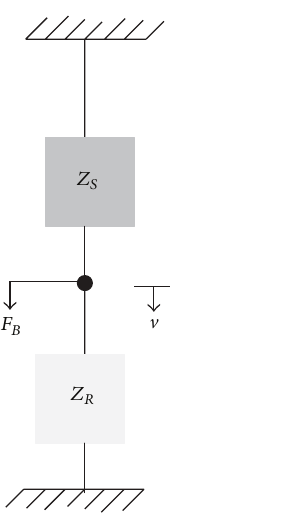
Figure 2: A source connected to a